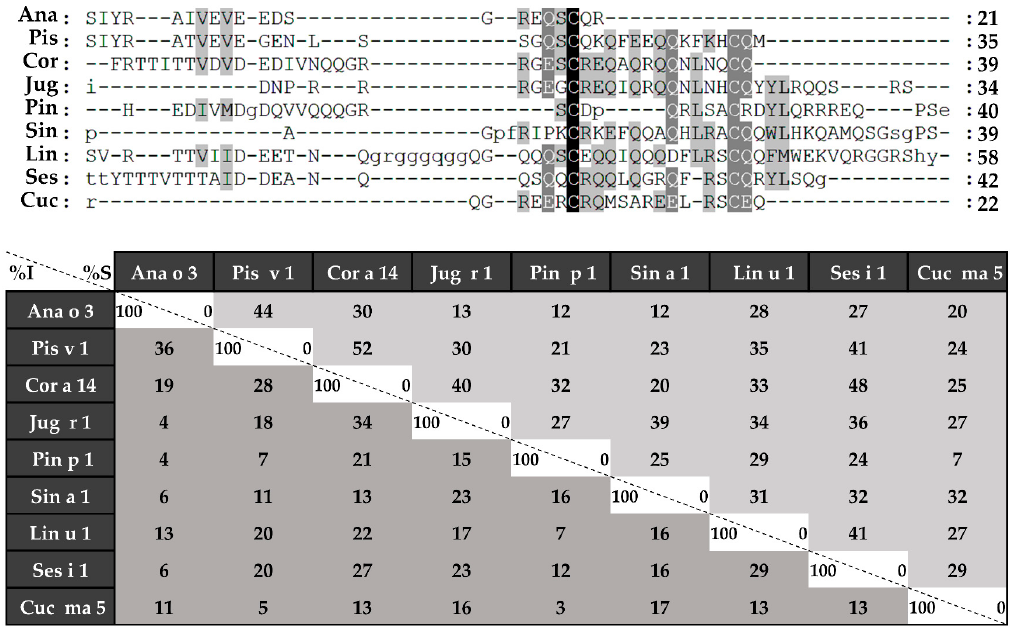
Figure 5. Amino acid sequence alignment of isolated 2S albumins light chains. The table under alignment shows percentages of identity (% I, dark grey) and similarity (% S, light grey).